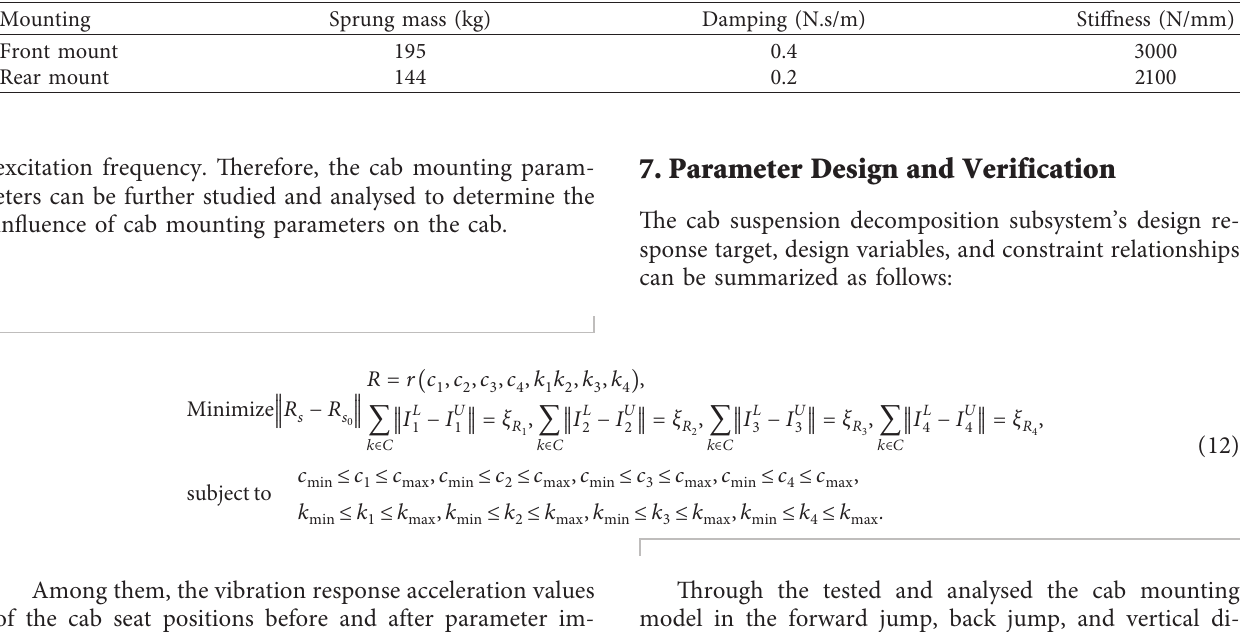
Table 3: Optimum stiffness damping value of component